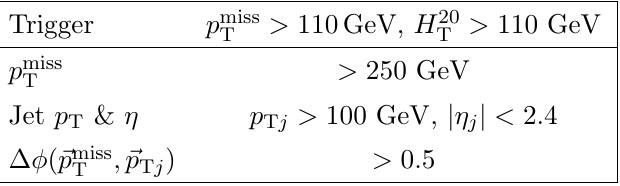
Table 6. Summary of selection cuts for the CMS mono-jet search [74]. Here H 20